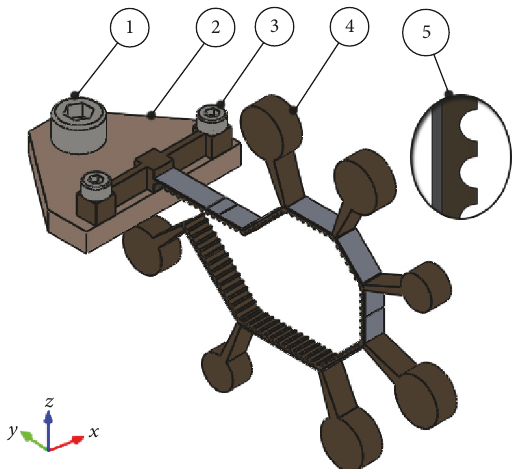
Figure 1: Isometric view of the energy harvester: A clamping bolt; B clamping frame; C M3 bolts for junction between the clamping frame and the harvester; D body of the polygon-shaped harvester; E design of cross-sectional